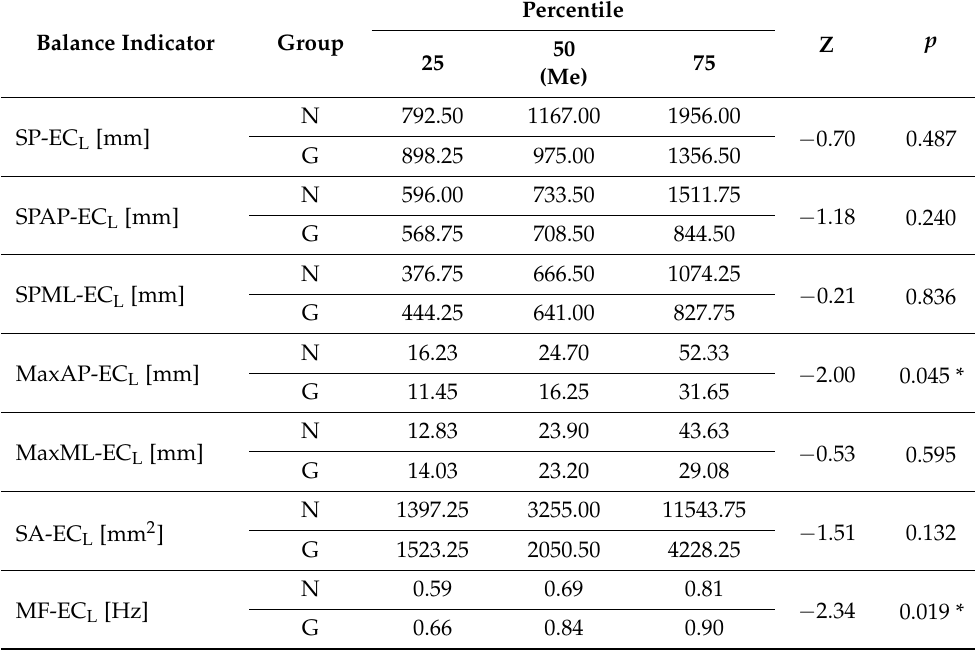
Table 3. Comparison of balance indicator values in tandem stance position with closed eyes and low (EC L ) between gymnasts and non-training